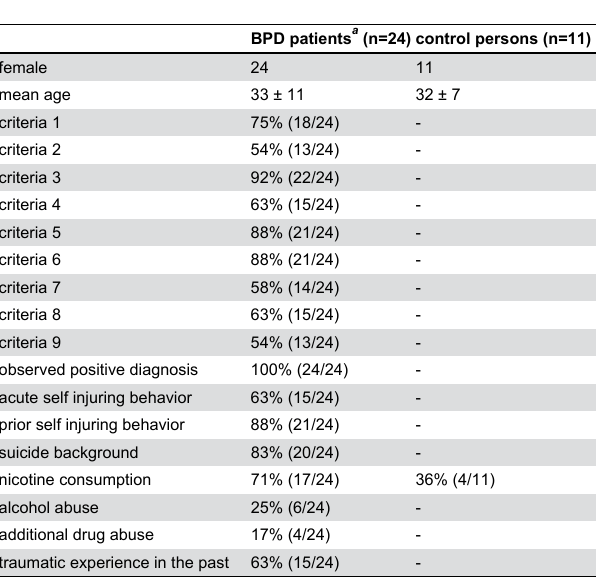
Table 1. Summarized data of the analyzed BPD patients and control